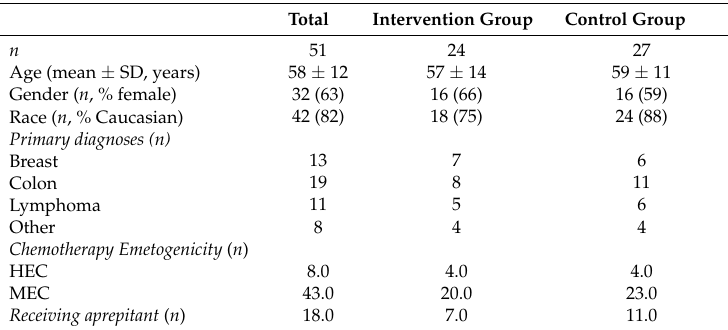
Table 1. Patient demographics at